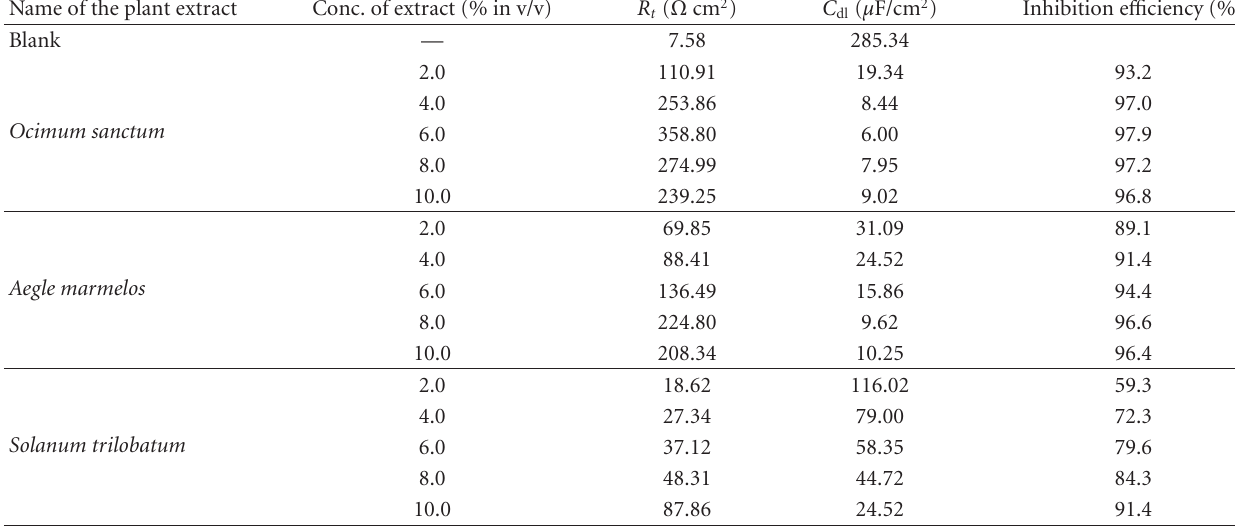
Table 4: Impedance parameters for the corrosion of mild steel in 1N HCl in the absence and presence of various concentrations of the plant extracts at 30 ◦